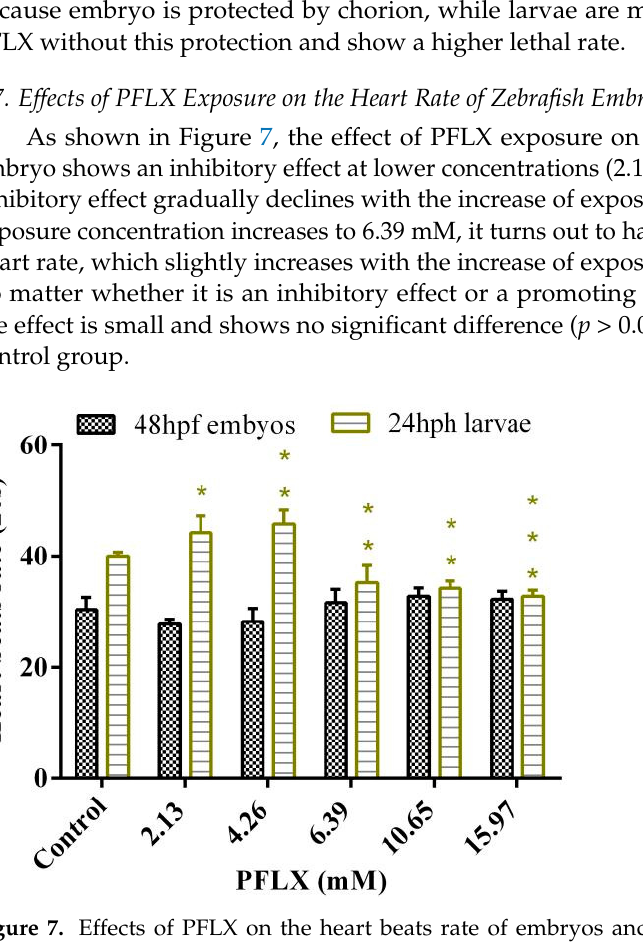
Figure 8. Teratogenic effect of PFLX on a zebrafish embryo.